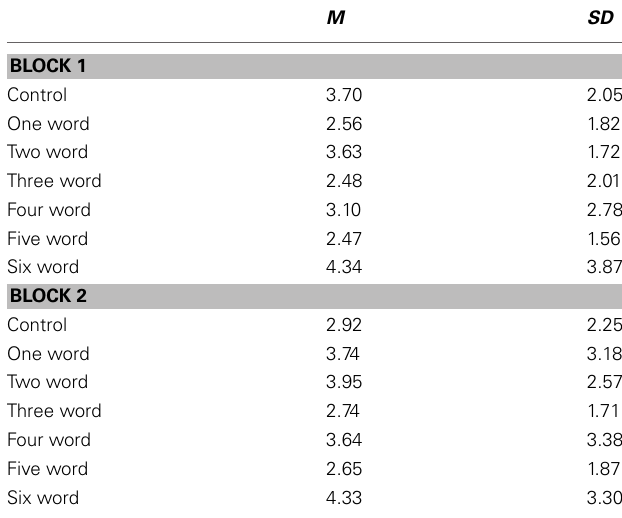
Table 1 | Percent errors in the lexical decision task as a function of block and